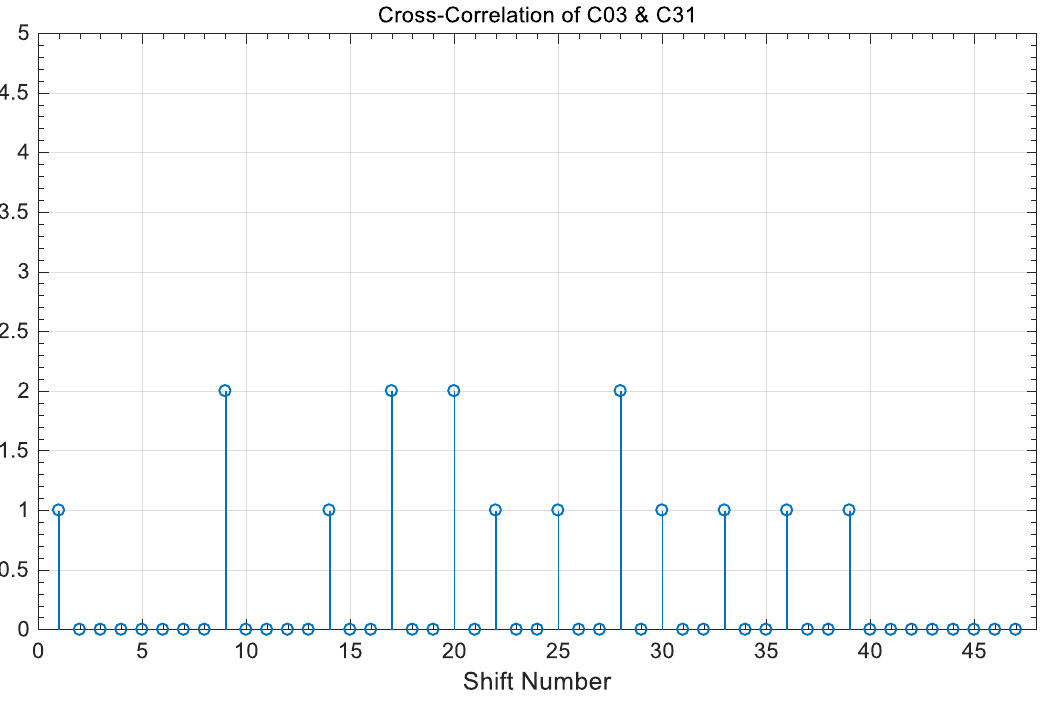
21 and C 43 sequences from different groups, P 1